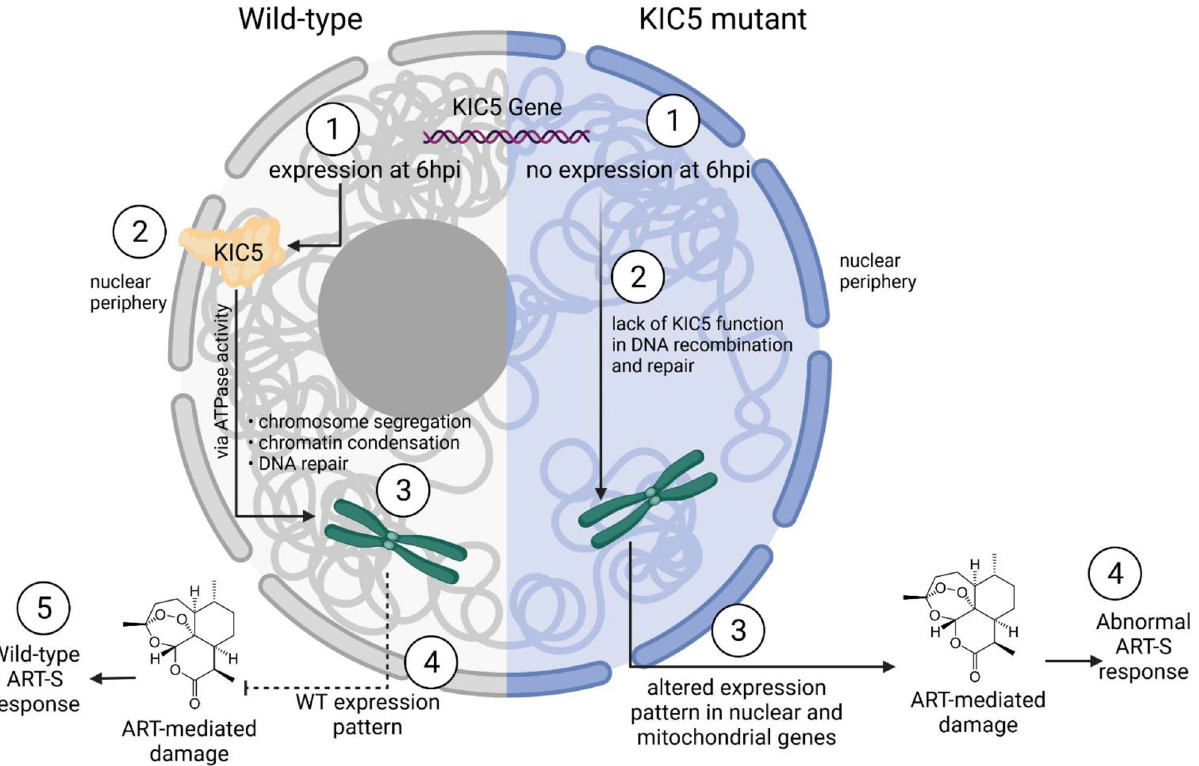
Figure 7. Mechanism of KIC5 mutant sensitivity to artemisinin due to the putative activity of the KIC5 protein. In the isogenic wild-type NF54 clone, KIC5 expression at 6 hpi leads to the gene’s activity in chromosome segregation, chromatin condensation, and DNA repair during ring stage, a critical period of artemisinin resistance in P. falciparum . KIC5 activity leads to wild-type expression pattern of stress response mechanisms under artemisinin exposure, leading to wild-type artemisinin sensitive phenotype. In the KIC5 mutant, however, dysregulation of KIC5 expression from 6 to 24 hpi leads to a lack of KIC5 protein activity during ring stage. Temporal changes to KIC5 activity led to altered expression of genes linked to artemisinin stress response, including various nuclear and mitochondrial pathways. Under artemisinin exposure, altered expression patterns lead to abnormal artemisinin response and increased sensitivity. Created with